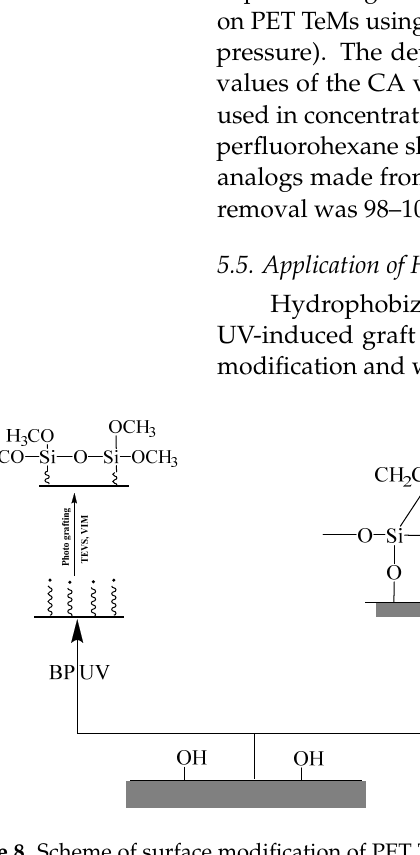
Figure 8. Scheme of surface modification of PET TeMs ( a ); water flux for modified PET TeMs-PDFTS and PET TeMs-g-TEVS ( b ) of pesticide solution (carbendazim) with different concentrations. Adapted from [184]. Table 2. Properties of PET TeMs before and after hydrophobization.